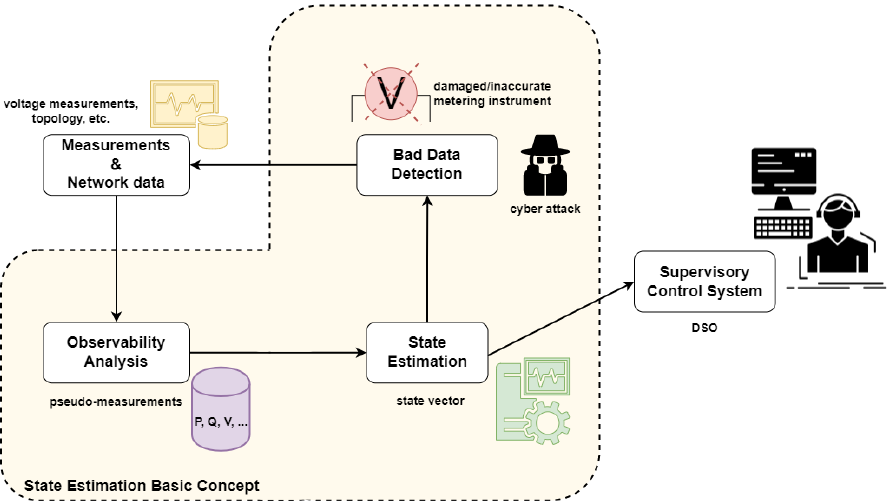
Figure 2. Basic concept of DSSE implementation.